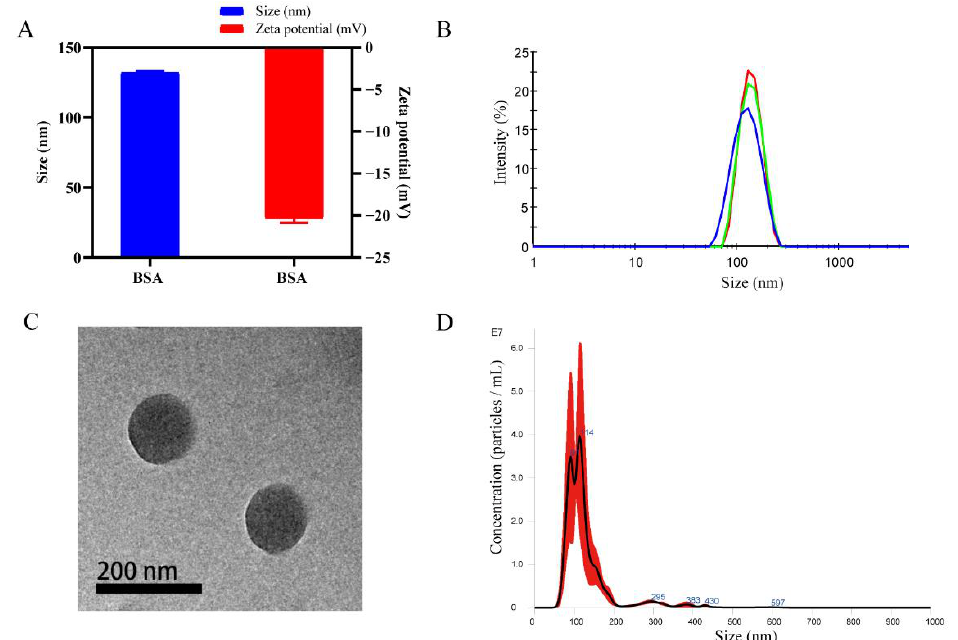
Figure 1. Characterization of BSA nanoparticles. ( A ) Hydrodynamic diameters and zeta potentials of BSA ( n = 3). ( B ) The hydrodynamic diameter distribution of BSA determined for 3 times. ( C ) Transmission electron microscopy image of BSA. Scale bar = 200 nm. ( D ) The average number of BSA nanoparticles after 1000-fold dilution ( n = 3).